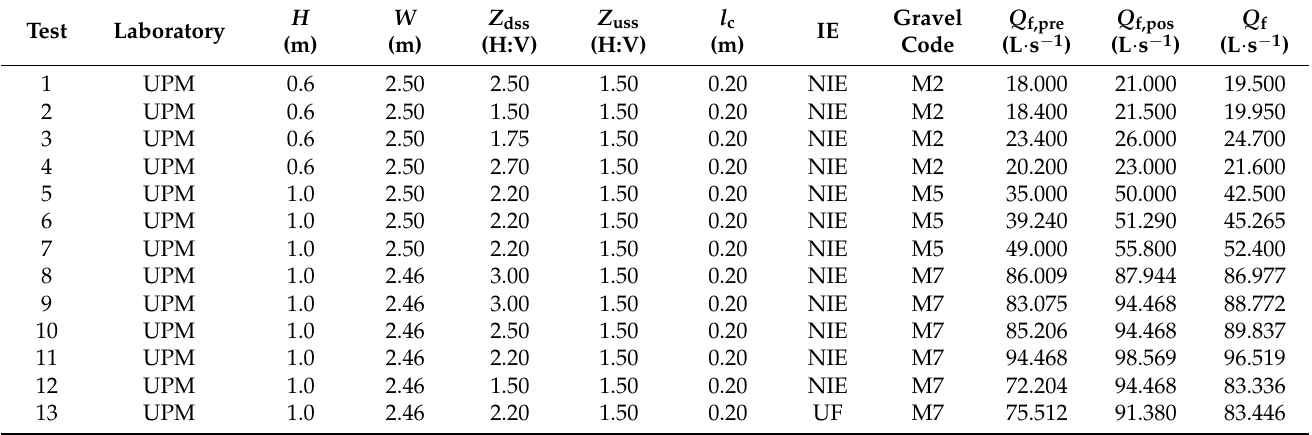
Table A1. Summary of the failure discharge ( Q f ) obtained for every physical model tested at the laboratory. The subscript ‘pre’ refers to the last discharge in which failure did not reach the crest, and ‘pos’ refers to the first in which failure surpasses it. The subscript ‘ave’ refers to the average value of the previous two. NA means ‘not